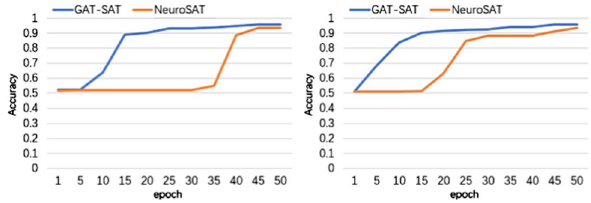
Fig. 5 The performance of GAT-SAT when NeuroSAT performs bet- ter (the right panel) and worse (the left panel) as a